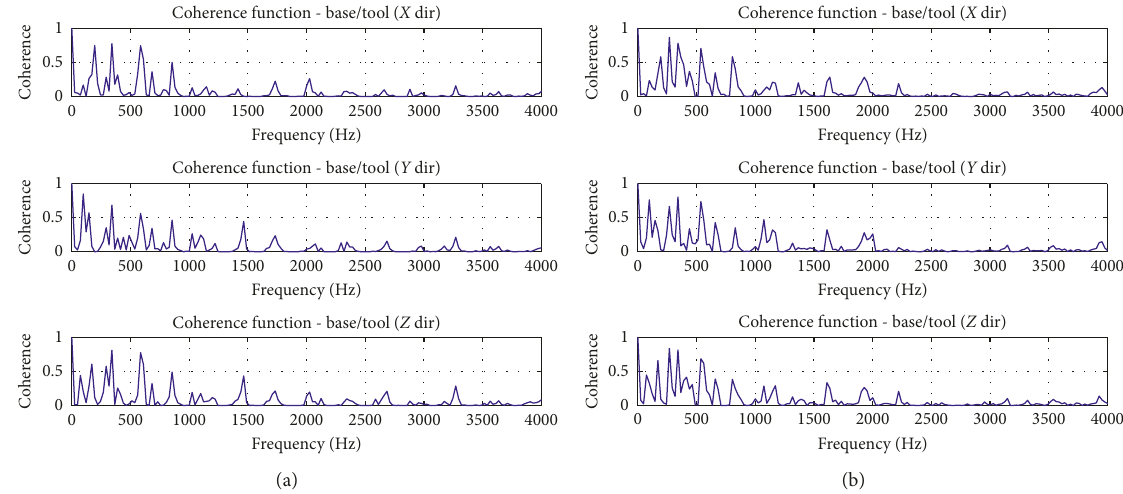
Figure 5: Coherence functions between the bed frame and milling head for the case of squared shape (a) and circular shape (b).